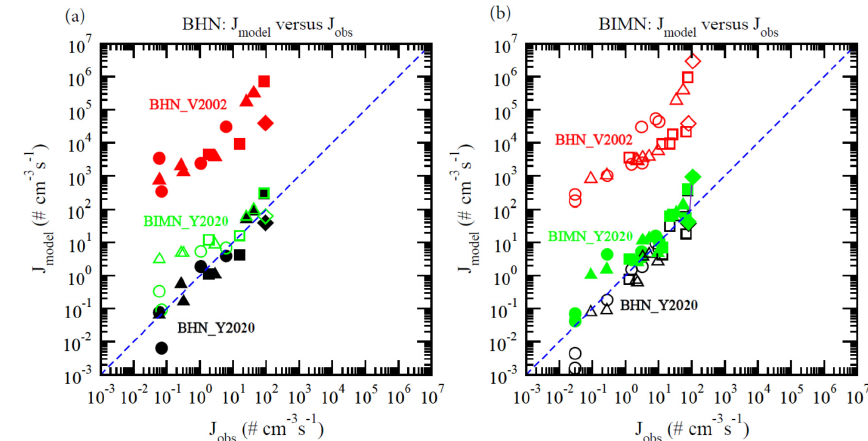
Figure 1. Comparison of nucleation rates based on three different schemes with CLOUD measurements within the low temperature range ( T = 205–223K) as that in the stratosphere for (a) binary homogeneous nucleation (no ionization) and (b) ion nucleation (at the presence of ionization rates 2.51–110ion pairscm − 3 s − 1 ). The different nucleation schemes shown are BHN of Vehkamäki et al. (2002) (BHN_V2002), BHN of Yu et al. (2020) (BHN_Y2020), and BIMN of Yu et al. (2020) (BIMN_Y2020). For comparison, under the binary condition of panel (a) , BIMN rates at Q = 20ion pairscm − 3 s − 1 are given, while under the binary ion nucleation condition of panel (b) , BHN rates are also given. Values of H 2 SO 4 vapor concentration ([H 2 SO 4 ]) range from 10 6 to 3 × 10 7 cm − 3 and are separated into four groups in the plots (circles: 10 6 –5 × 10 6 cm − 3 , triangles: 5 × 10 6 –10 7 cm − 3 , squares: 10 7 –1 . 5 × 10 7 cm − 3 , diamonds: 1 . 5 × 10 7 –3 × 10 7 cm − 3